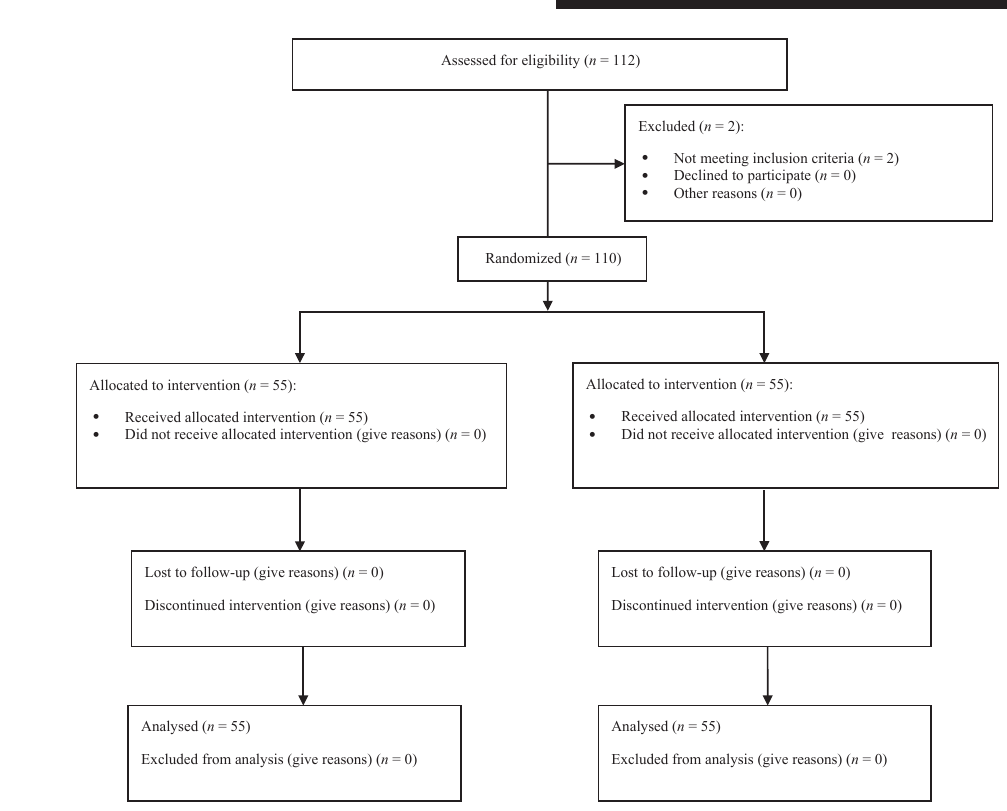
Figure 1. Consort flow